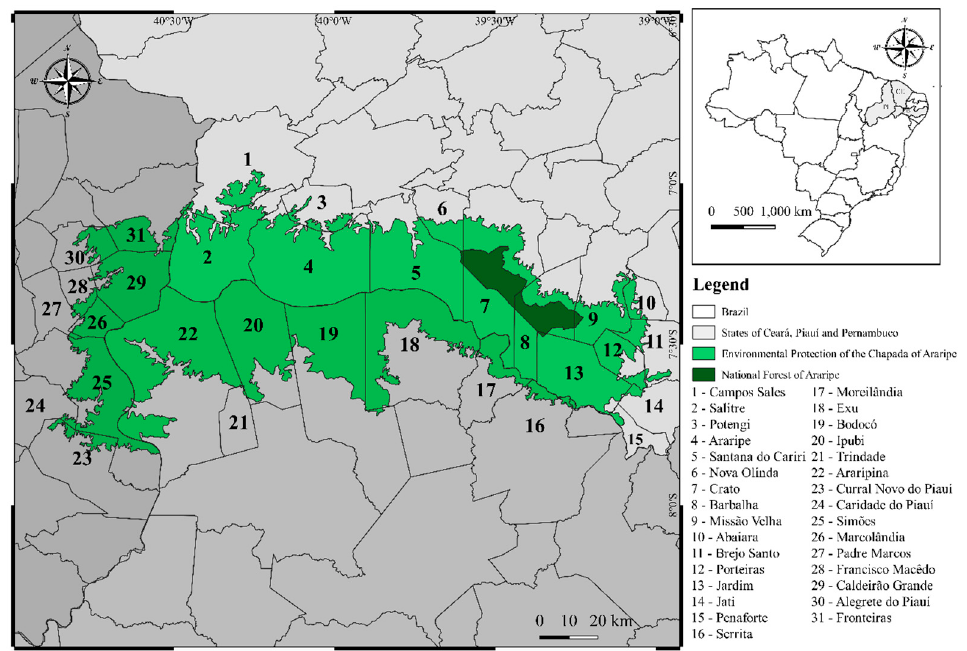
Figure 2. Map of the Araripe Environmental Protection Area (APA—Araripe, Cear á , Brazil) where Figure 2 . Map of the Araripe Environmental Protection Area (APA—Araripe, Ceará, Brazil) where Caryocar coriaceum Wittm. (Caryocaraceae) occurs Caryocar coriaceum Wittm. (Caryocaraceae) occurs spontaneously.